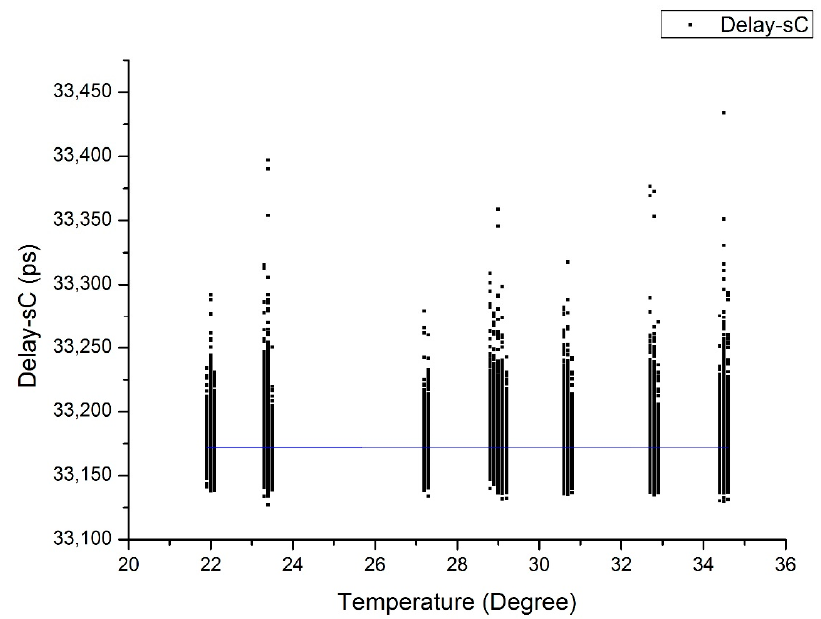
Figure 4. Delay over temperatures after compensation in the temperature stable period. (The black dots are delay after compensation, and the blue line is the one-order fitting curve.)